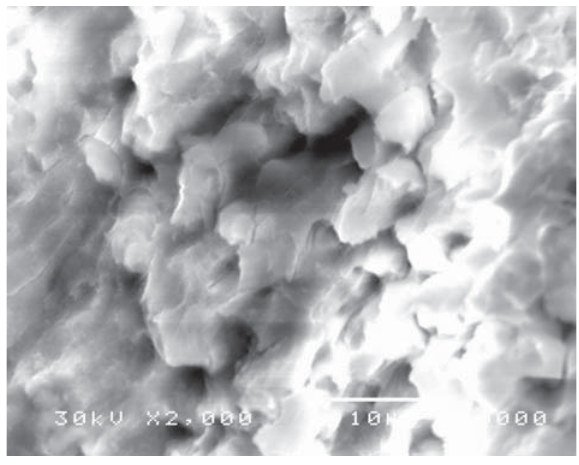
Figure 9- Electron-micrograph in control (CL) group after cavity preparation with laser showing irregular dentinal tubules with partially obliterated lumen intermingled with areas where the (cid:87)(cid:88)(cid:69)(cid:88)(cid:79)(cid:68)(cid:85)(cid:3)(cid:86)(cid:87)(cid:85)(cid:88)(cid:70)(cid:87)(cid:88)(cid:85)(cid:72)(cid:3)(cid:70)(cid:68)(cid:81)(cid:182)(cid:87)(cid:3)(cid:69)(cid:72)(cid:3)(cid:76)(cid:71)(cid:72)(cid:81)(cid:87)(cid:76)(cid:191)(cid:72)(cid:71)(cid:3)(cid:11)(cid:91)(cid:21)(cid:15)(cid:19)(cid:19)(cid:19)(cid:12)